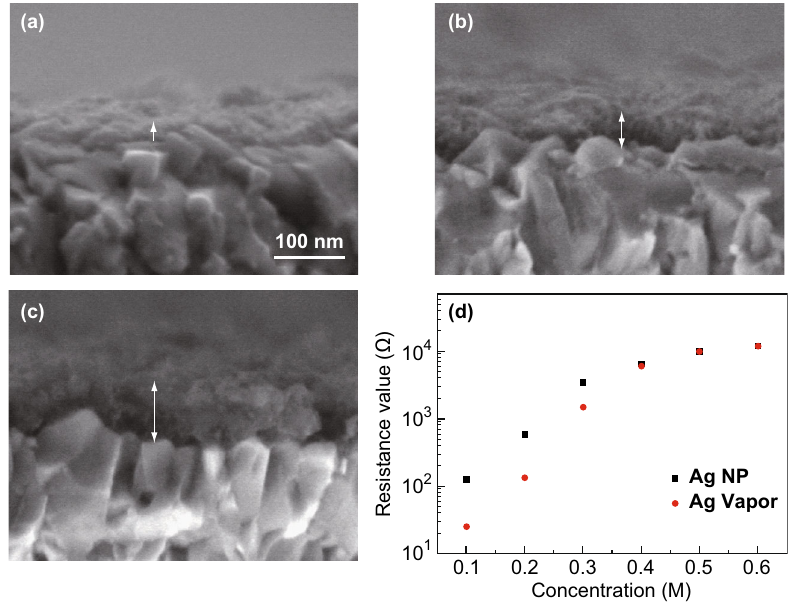
Fig. 3 Cross-sectional SEM images of the TiO 2 films prepared at different concentrations of TiCl 4 a 0.2 M, b 0.4 M, c 0.6 M. Panels a – c have the same scale-bar of 100 nm. d Average resistance between Ag spots on TiO 2 layers prepared using different concentrations of TiCl 4